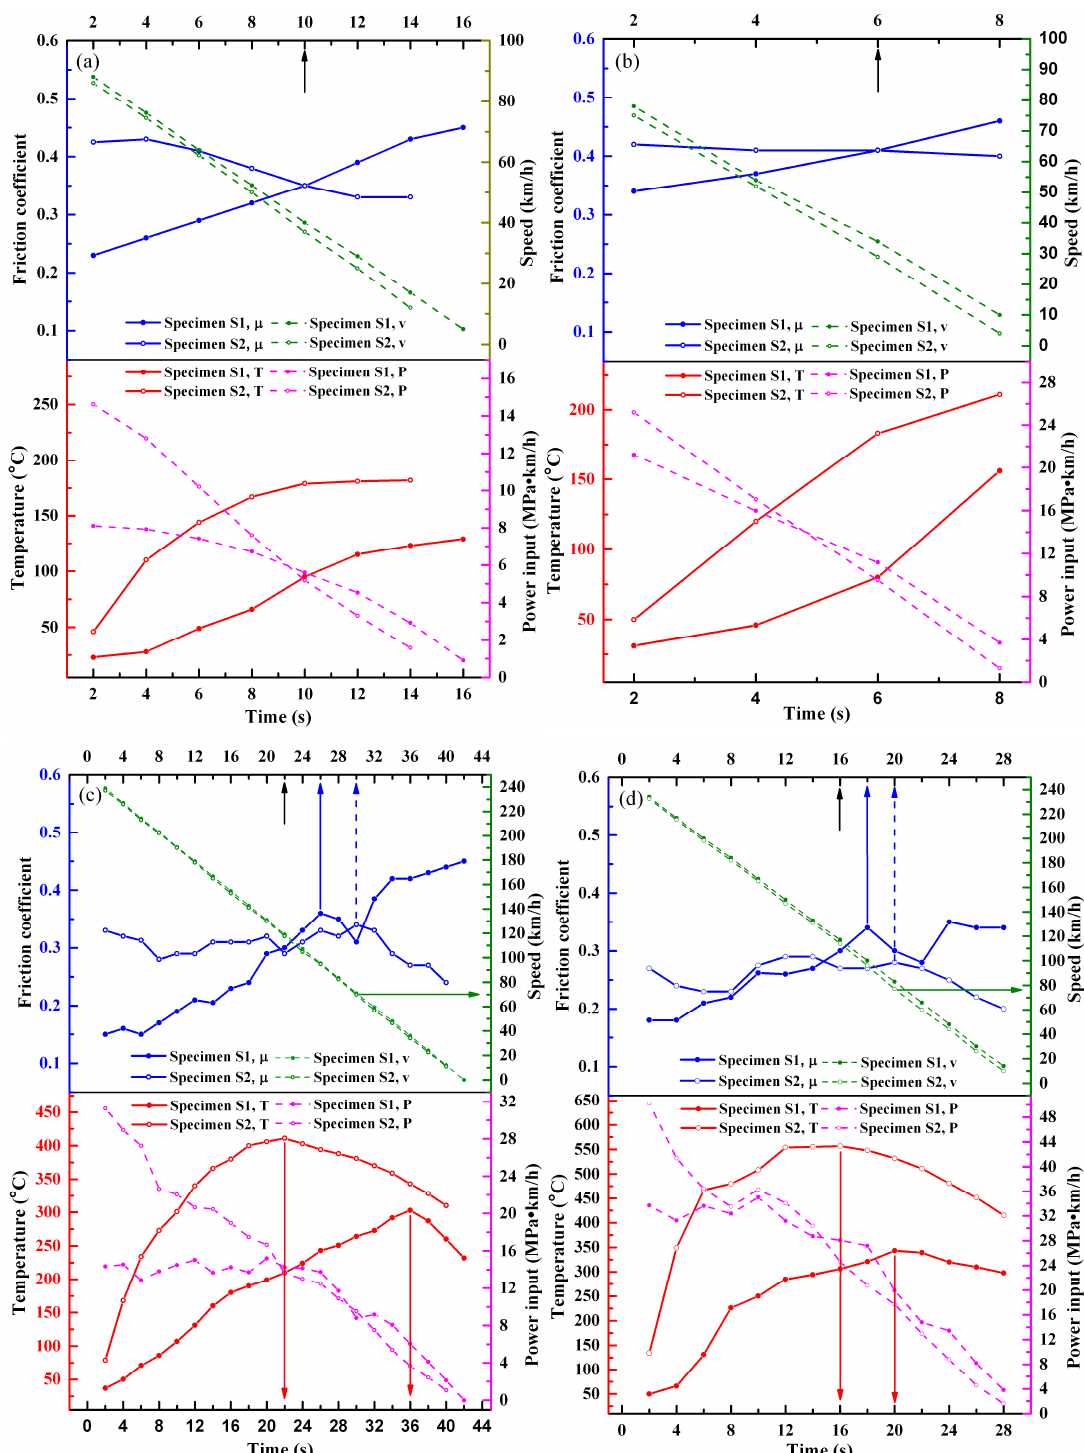
Figure 7. The variation of friction temperature (T), instantaneous friction coefficient ( µ ), speed (v), and power input (P) during the braking process under different test conditions: ( a ) 100 km/h, 0.4 MPa;